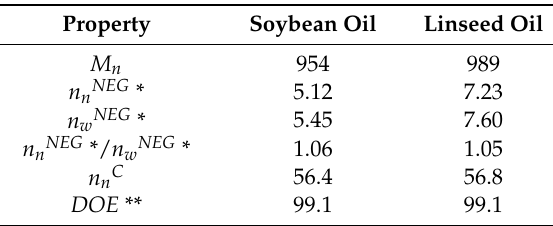
Table 2. Characterization of the epoxidized soybean and linseed